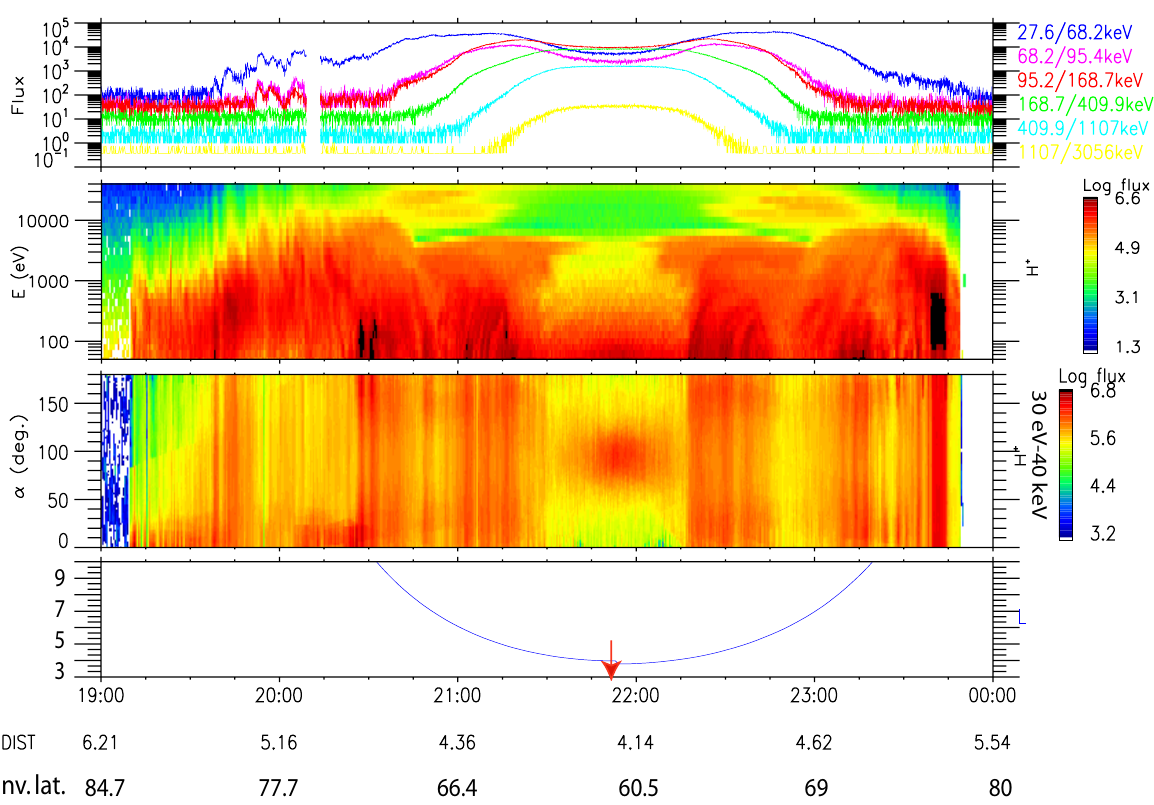
Fig. 2. SC4 particles data for the 21 November 2001 event. From top to bottom: RAPID proton flux in flux units, CIS/CODIF proton flux in flux units, the proton pitch angle distribution in flux units for the 30eV–40keV energy range and the L-shell values crossed by the spacecraft. Radial distance in R E and invariant latitudes are indicated at the bottom of the plot. Red arrow indicated the equator